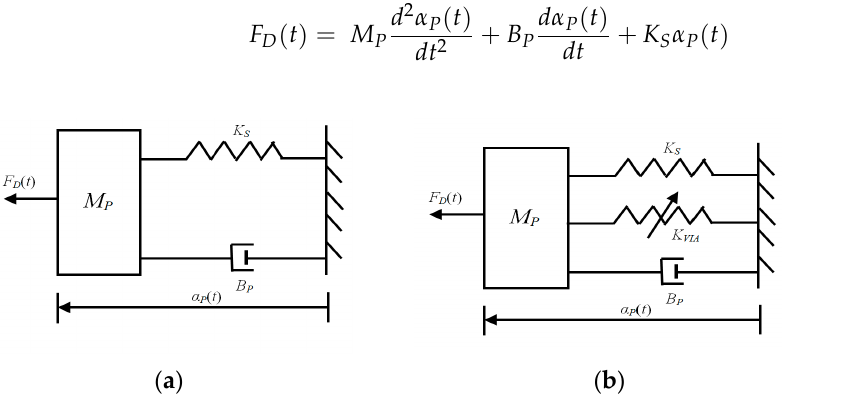
Figure 2. Mechanical model equivalent of the pedal dynamics; ( a ) accelerator pedal, ( b ) active ac- celerator pedal. accelerator